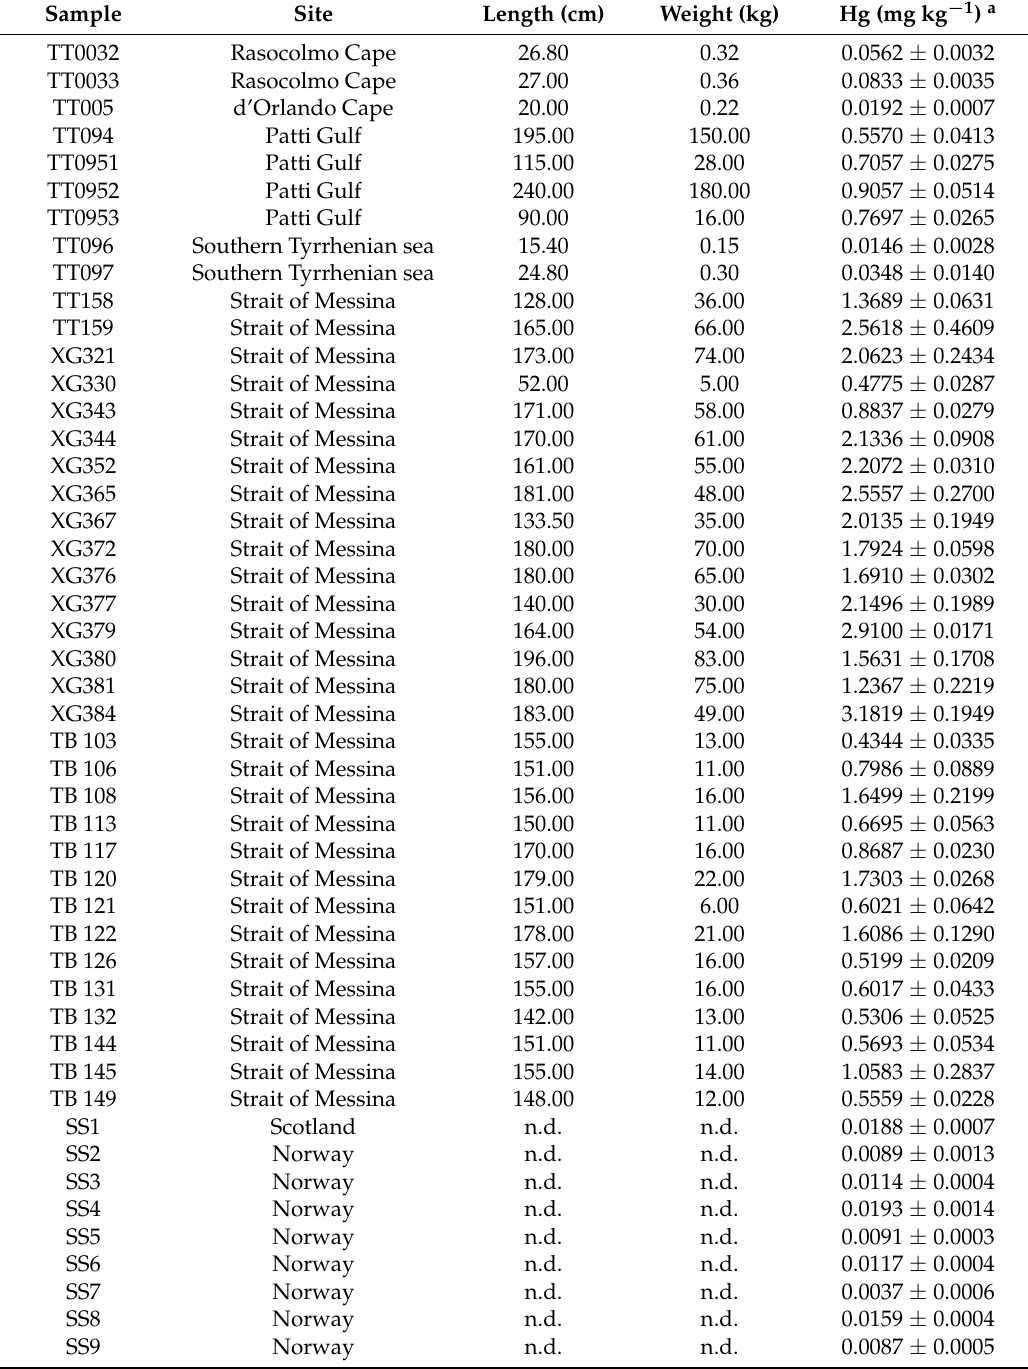
Table 1. Sample information: Site of collection, length (cm) and weight (kg), concentration levels of Hg expressed as mg kg − 1